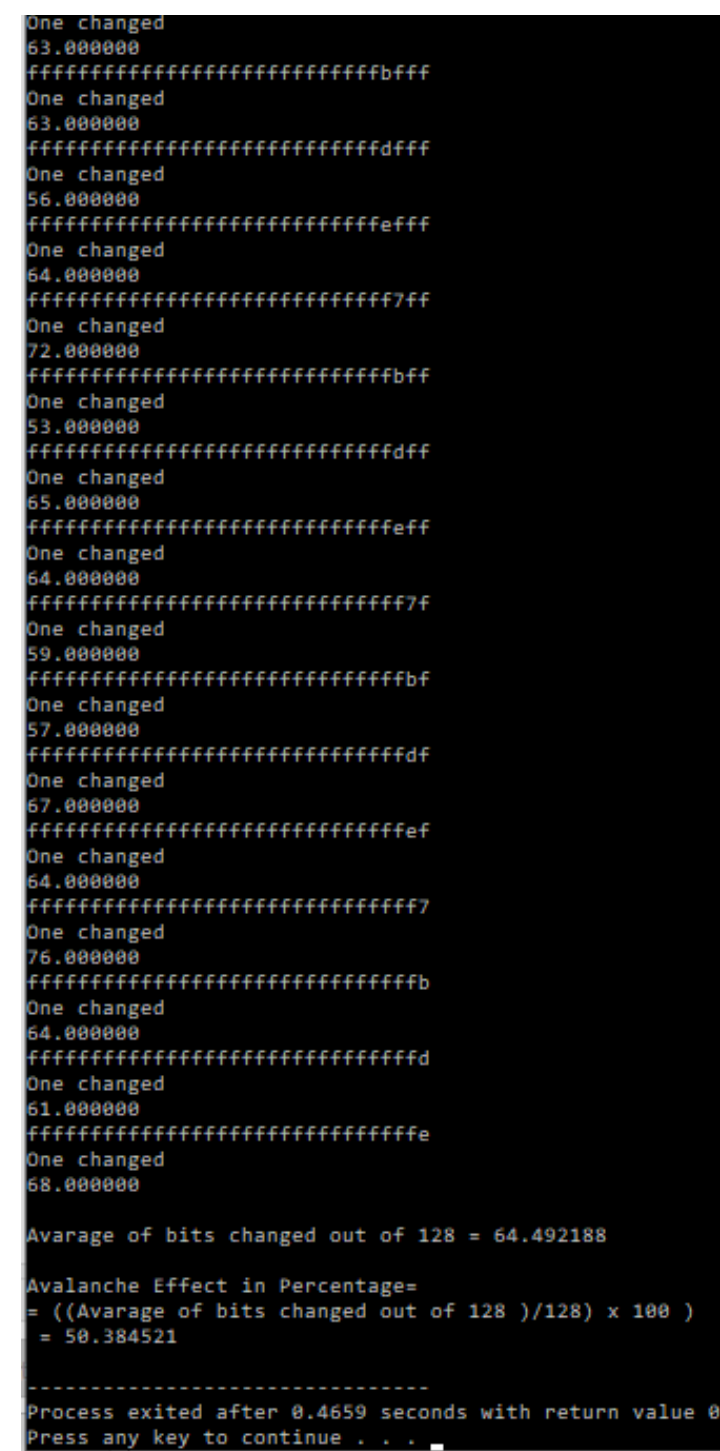
Figure 10. Experimental Avalanche Effect of Serpent when one bit of a plaintext was